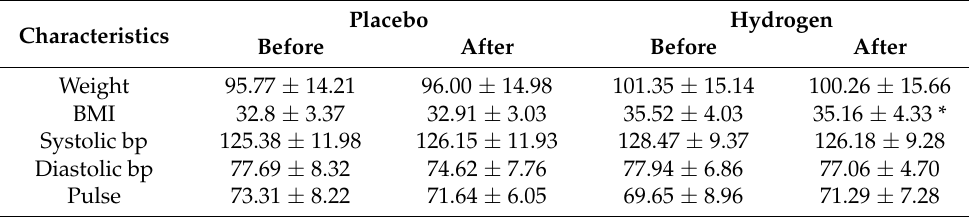
Table 2. Changes in anthropometric characteristics from baseline to 8-week follow up.